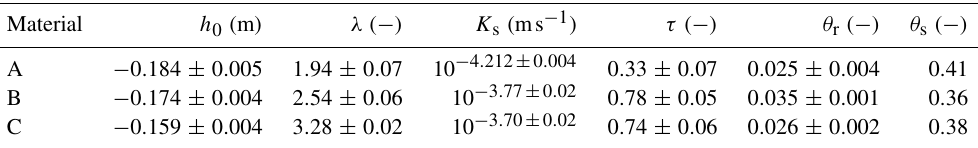
Figure 10. The standardized residuals of the 2-D study are visualized over time (a, c, e) and in a probability plot (b, d, f) for all TDR and hydraulic potential sensors. The color associates the results with the four setups of the study (basic, position, Miller, and Miller and position). Same as for the 1-D study, the standard deviation for the TDR measurement data is chosen as 0.007. We choose the standard deviation for both the manual measurements in the groundwater well and the tensiometer measurement data as 0 . 025m. The representation of uncertainties with respect to the sensor positions and small-scale heterogeneities improves the description of the TDR data quantitatively. The decreasing slope of a linear fit (thin lines in the probability plots), which is based on the standardized residuals within [− 2 , 2 ] theoretical quantiles, also indicates this improvement. The structural model–data mismatch for the hydraulic potential data is mainly due to (i) uncertainties concerning the position of the tensiometer and (ii) unrepresented 3-D flow phenomena. Table 7. We present the effective hydraulic material parameters obtained with the Miller and position setup of the 2-D study. The formal standard deviations of the parameter estimation are given with the understanding that these are specific to the applied algorithm and will change for different algorithm parameters. The estimations for the saturated hydraulic conductivity of the gravel layer and for the offset to the Dirichlet boundary condition are 10 − 0 . 728 ± 0 . 006 ms − 1 and − 0 . 034 ± 0 . 001m,